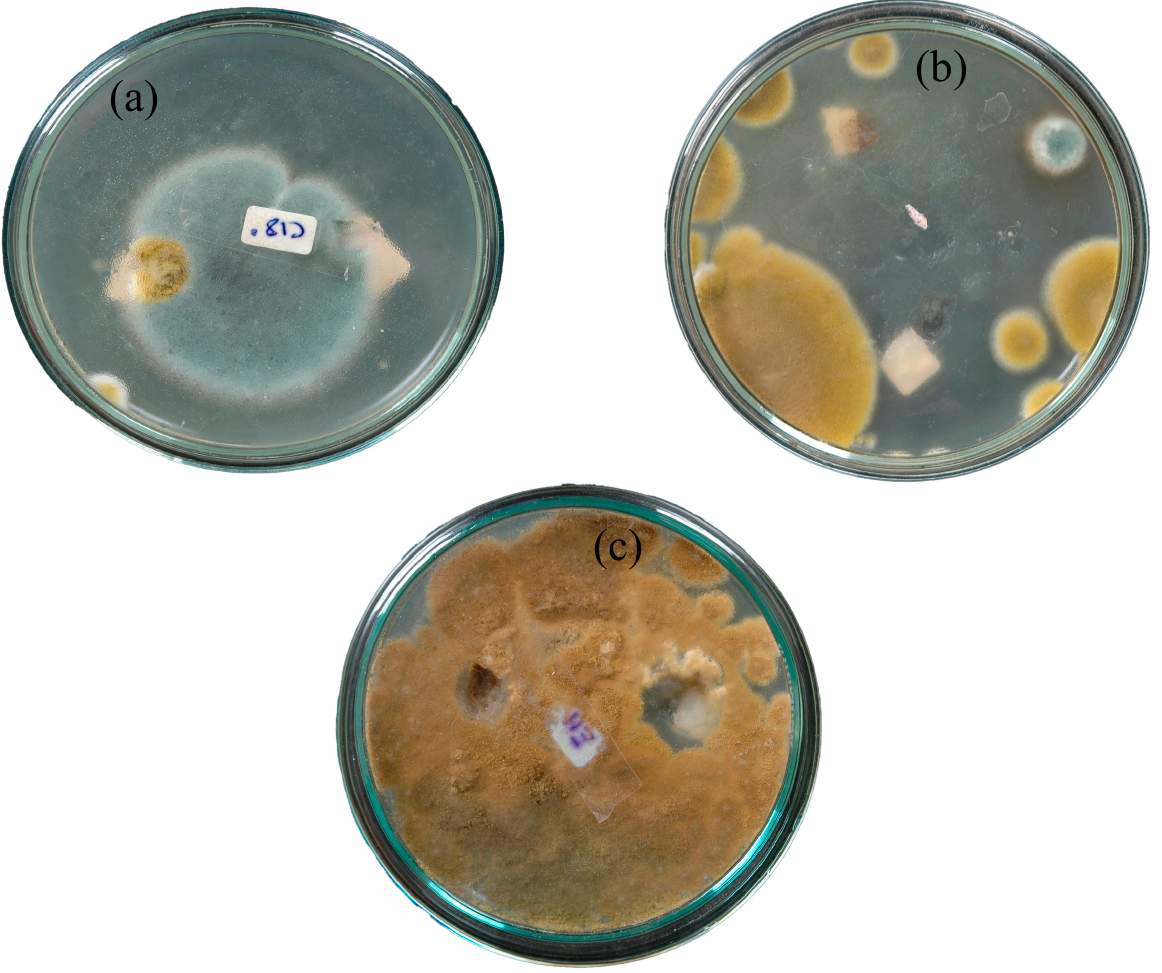
Figure 6. The antifungal inhibition zones of Ni(II) complex ( a ), Cu(II) complex ( b ), and Zn(II) complex ( c ) against Aspergillus oryzae .